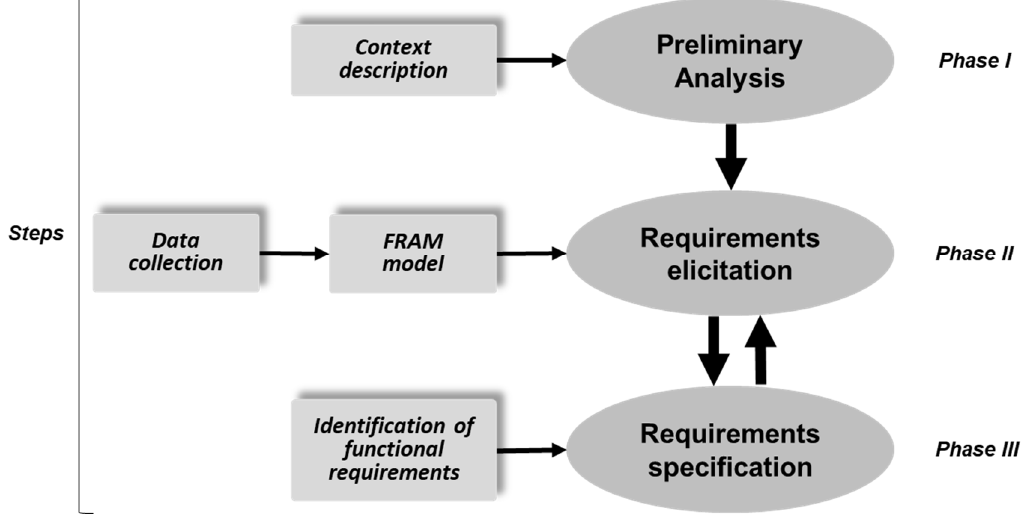
Figure 2. The proposed method’s framework for requirements elicitation and specification using the FRAM model .